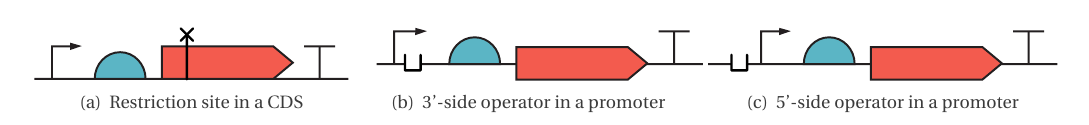
Figure 13: Examples where glyphs SHOULD overlap, but might not if it is more clear, e.g., with an operator site located within the 5’ portion of a promoter.